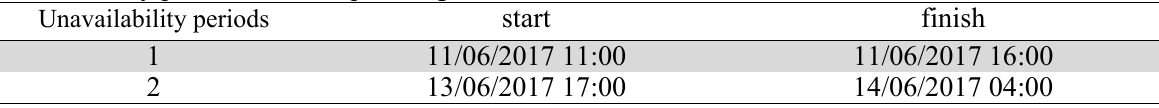
Unavailability periods over the planning horizon